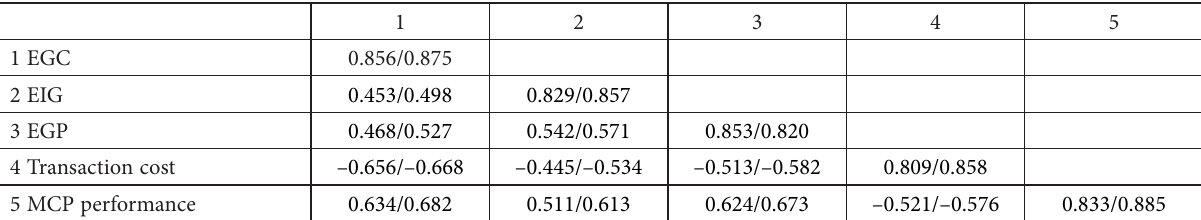
Table 4. AVE values and correlations of the constructs